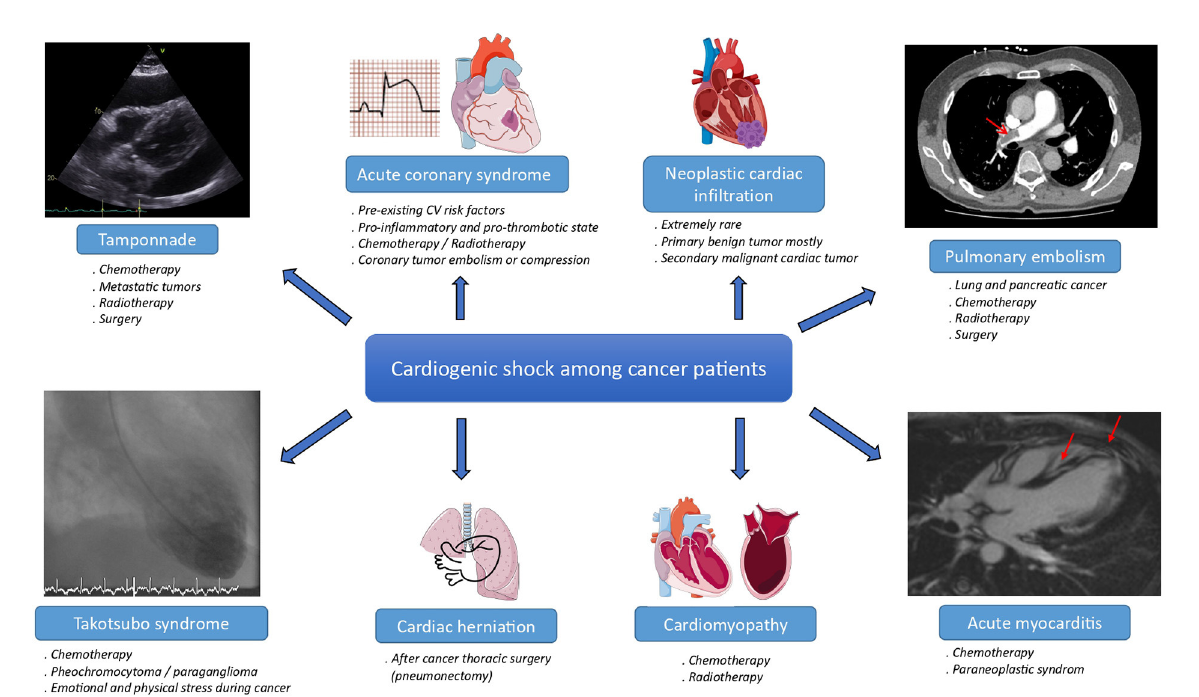
FIGURE1 Main etiologies of cardiogenic shock among cancer patients. CV, cardiovascular. The meaning of the red arrow is “Magnetic resonance imaging of acute